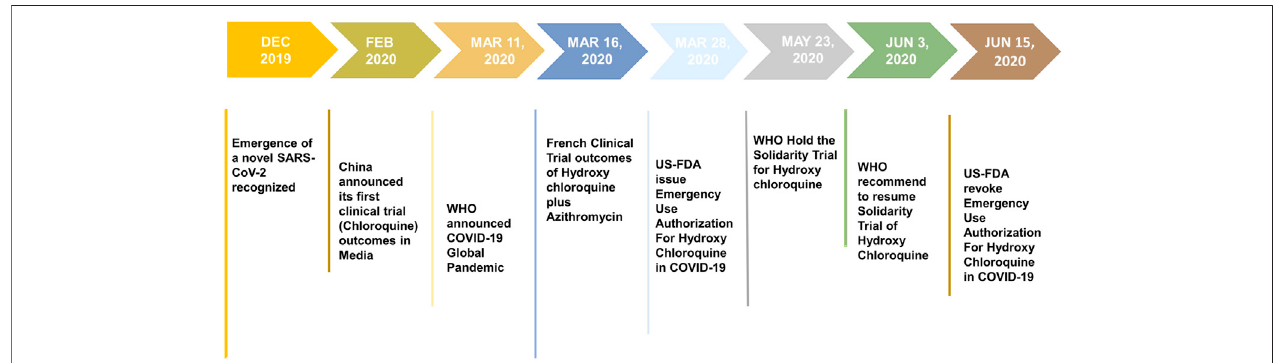
FIGURE 2 | Various stages of development of chloroquine (CQ) and hydroxychloroquine (HCQ) as compassionate therapy.